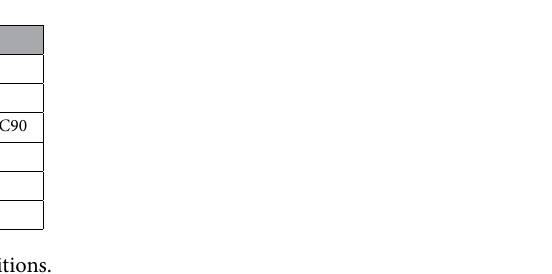
Figure 11. Sliding velocity for different fullerene molecules on a gold substrate for 75 K ( A ), 150 K ( B ), 300 K ( C ), 400 K ( D ), 500 K ( E ) and 600 K ( F ). The blue, red, black and yellow bars show sliding velocity of the molecules on the flat, down side of the step, top side of the step, and concave substrates, respectively.